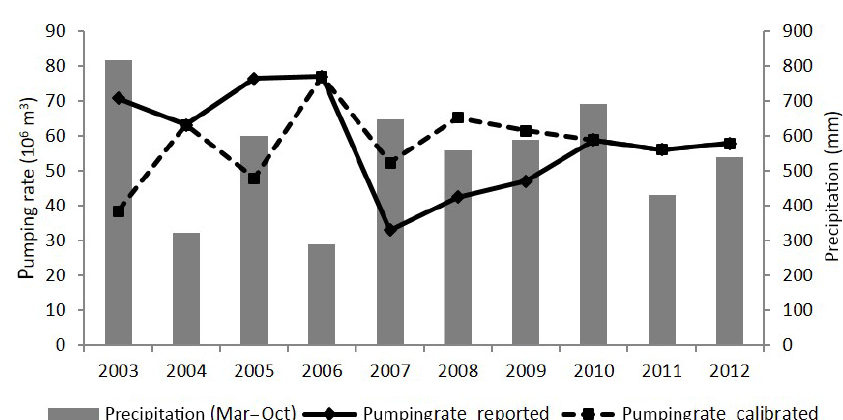
Figure 1. Schematic map of the NCP (a) and administrative map of Guantao (b) .